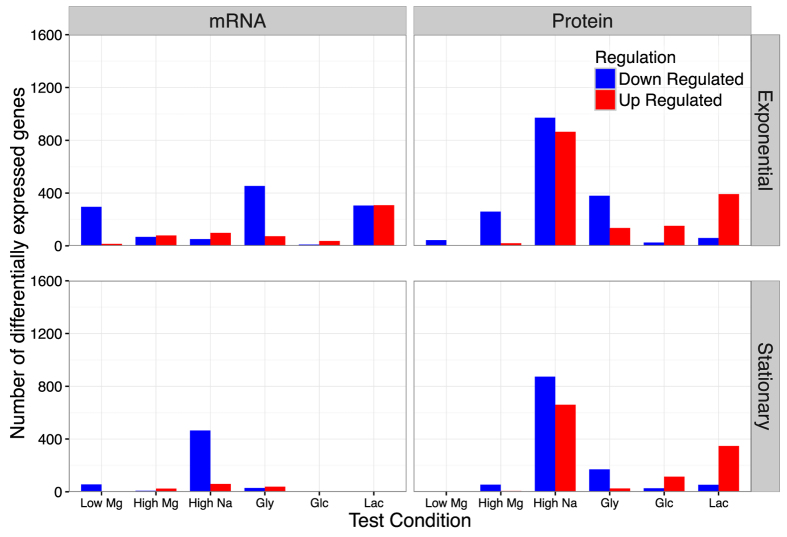
Number of differentially expressed genes under different conditions.We separately analyzed mRNA and protein abundances, each for both exponential and stationary growth phase. In all four cases, gene expression levels were compared to the corresponding condition with glucose as carbon source and baseline sodium and magnesium levels. Differentially expressed genes were defined has having at least a two-fold change relative to baseline and a false-discovery rate <0.05. Carbon sources are abbreviated as follows: “Gly”: glycerol, “Glc”: gluconate, “Lac”: lactate.